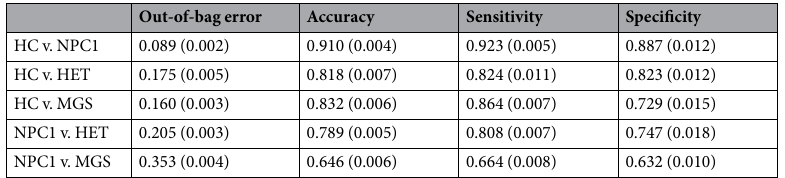
Table 2. Random forest classification performances of training and test sets. Mean